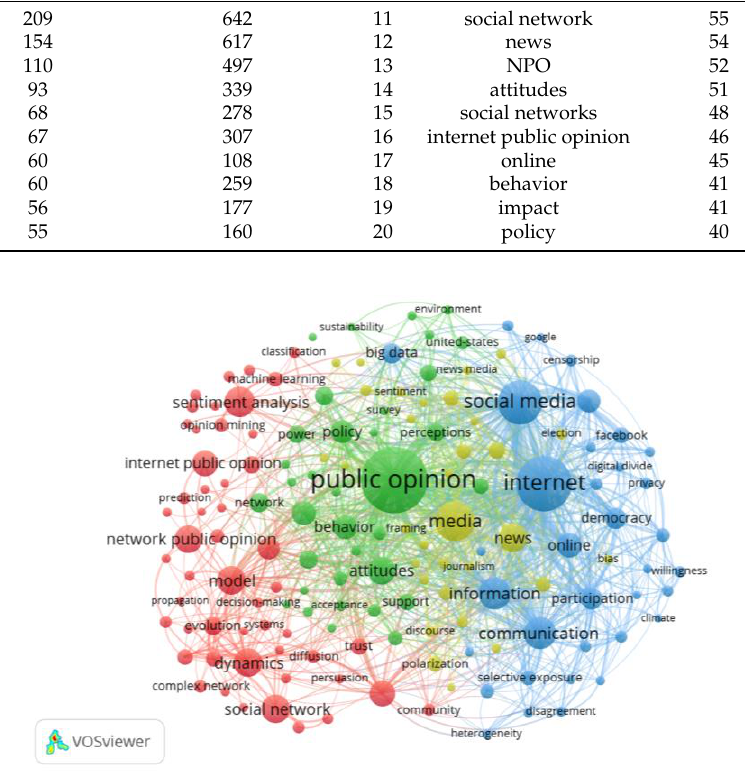
Figure 13. The journal co-citation network of NPO publications.